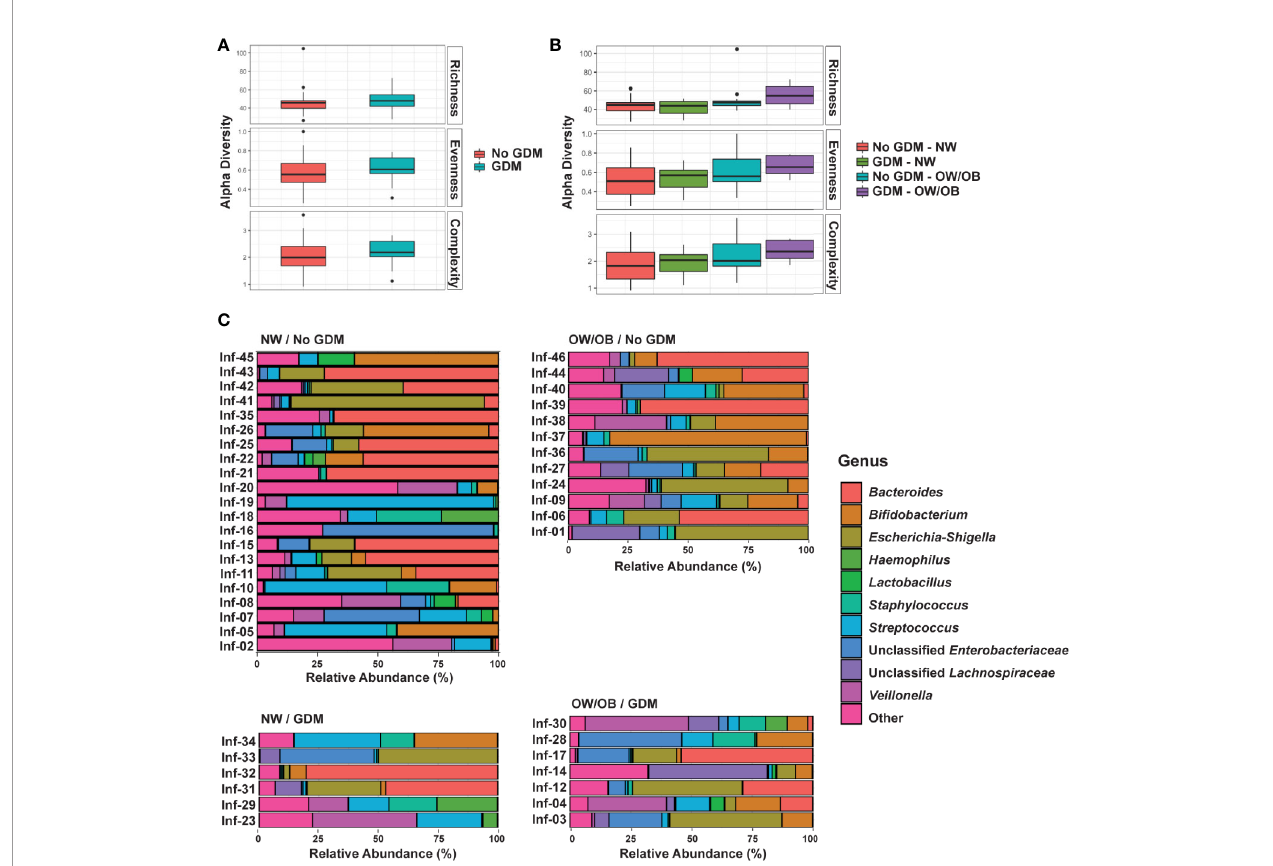
FIGURE 1 | GDM and maternal overweight/obesity alter infant gut microbiota. Box plots of genus-level alpha diversities richness (Chao1), evenness (Shannon H H and complexity (Shannon H) by (A) GDM and (B) GDM and weight group. Black dots represent outliers within strata. (C) Relative abundance of microbiota taxa for each infant at the genus level. Genus-level taxa shown are the 10 most abundant with the remaining classi fi ed as Other. Relative abundance estimated using negative binomial regression on 16S rRNA gene amplicon sequences from stool samples, shown as percent of total. GDM, gestational diabetes; NW, normal-weight; OW/OB,